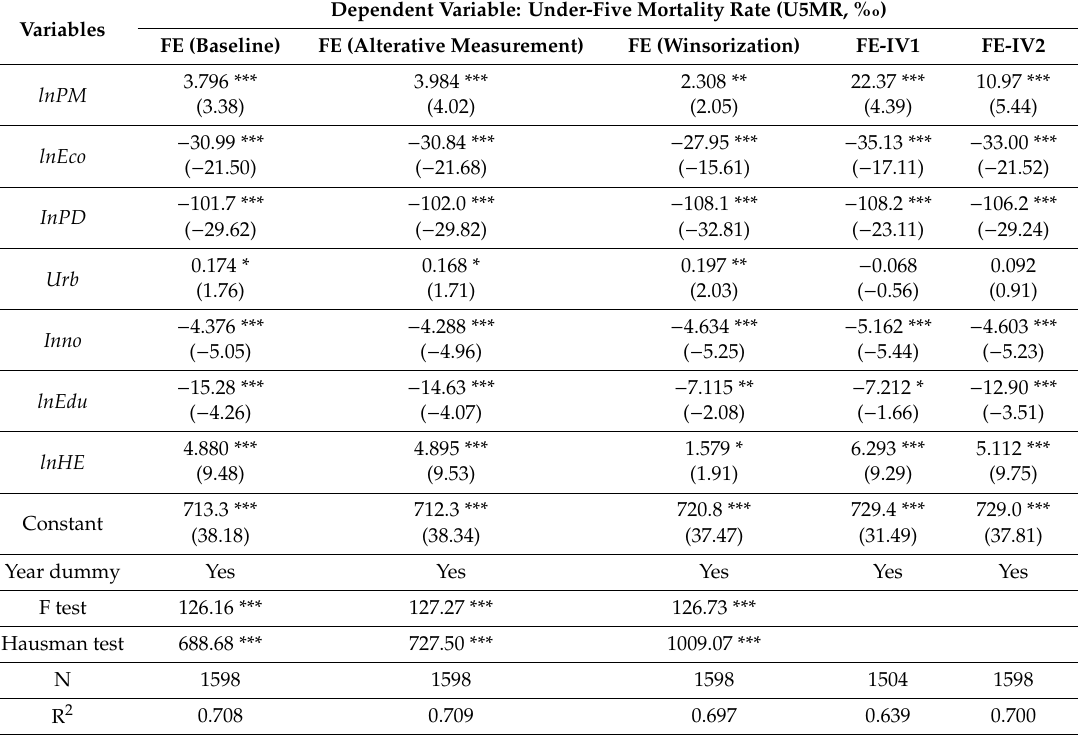
Table 4. Estimation result in the full